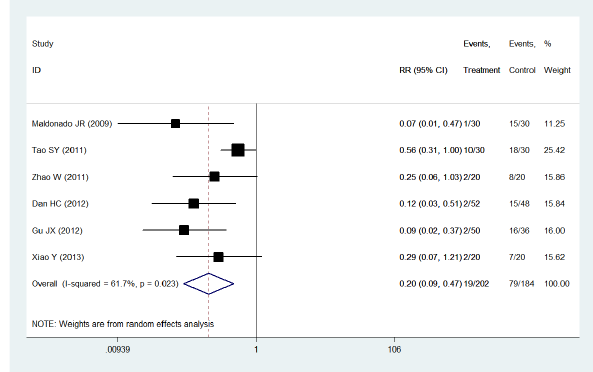
Figure 3: Forest plot of postoperative delirium risk between dexme- detomidine and midazolam